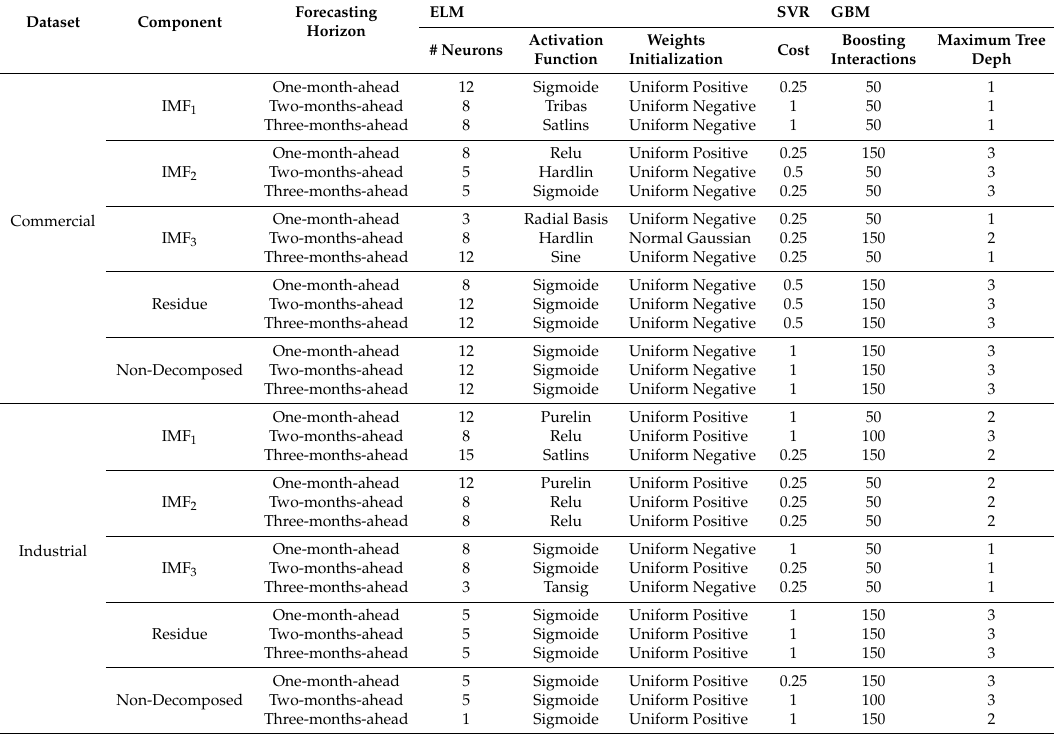
Figure 6 summarize the main steps used in data analysis.